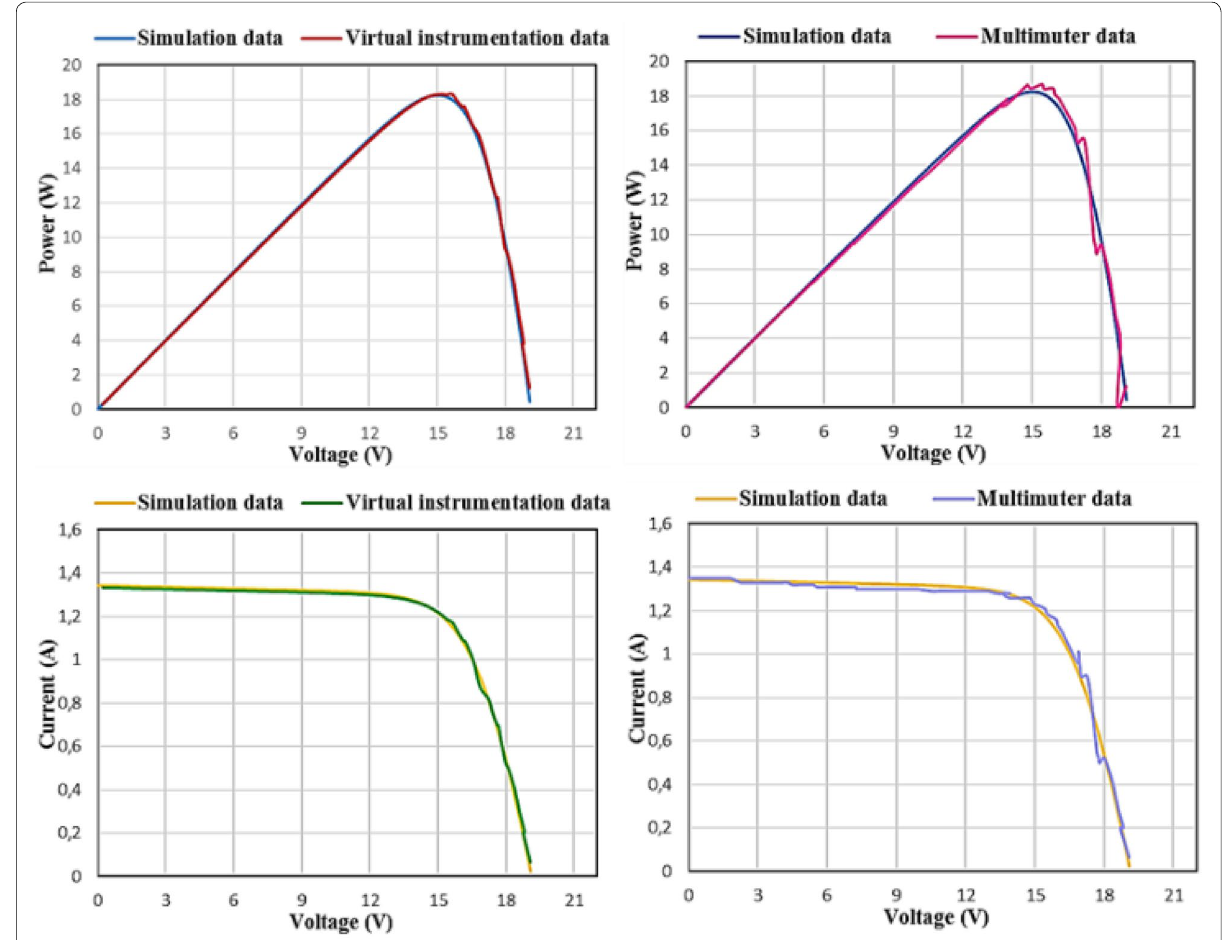
Fig. 18 I – V and P – V model curves and experimental data of PV